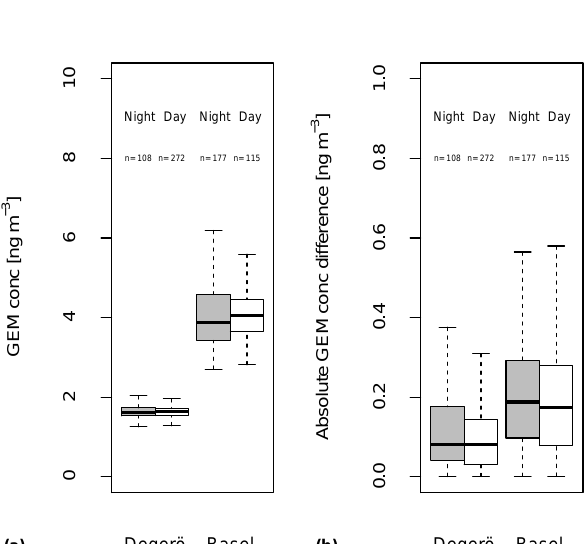
Figure 7. Box plots display atmospheric GEM concentrations (a) and the absolute GEM concentration differences between updraft and downdraft (b) during the day and night at Degerö and Basel.. Number of observations is indicated. The bold line in the box rep- resents the median GEM concentration. The horizontal border lines indicate the 25th (Q1) and 75th (Q3) percentiles, from bottom to top. The lower whisker marks Q1 minus 1.5 times the interquartile range (IQR). The upper whisker marks Q3 plus 1.5 IQR. Outliers are not